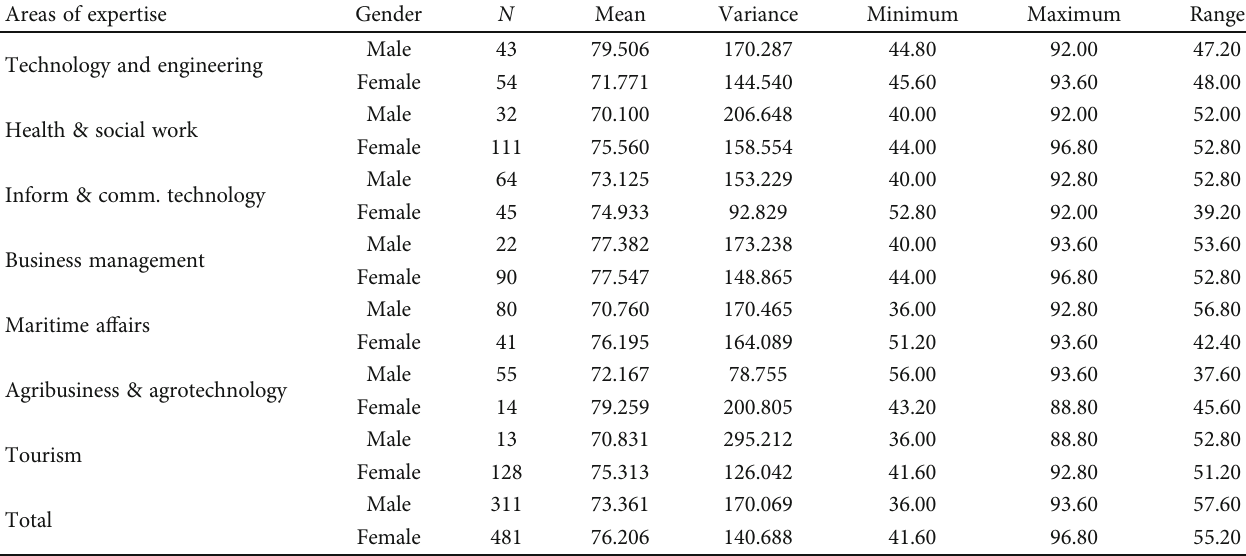
Table 1: Descriptive statistics of students ’ ESE